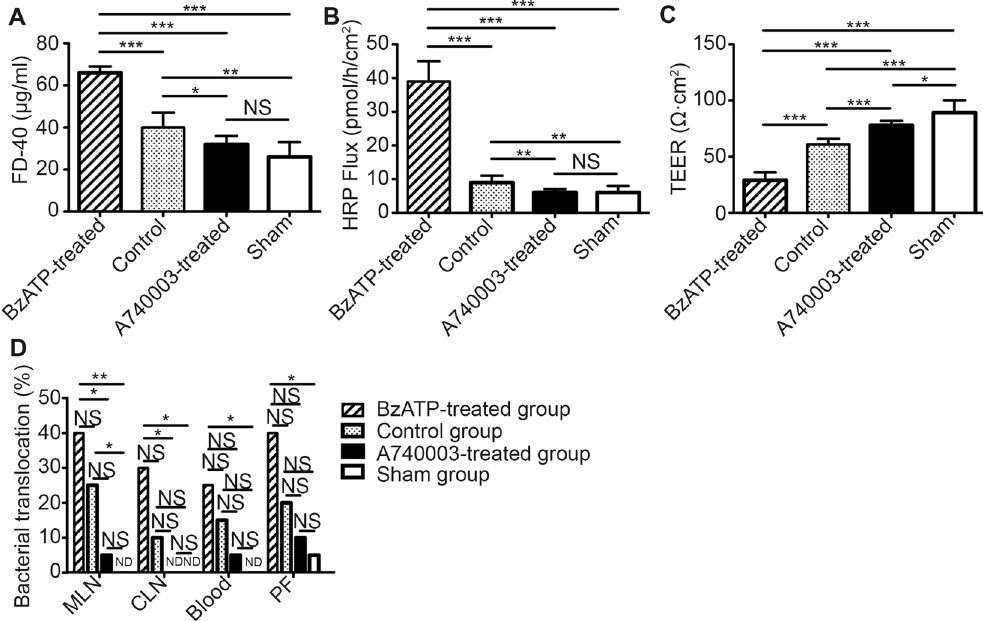
Figure 3. The effects of a P2X7R blockade on intestinal permeability and bacterial translocation. In vivo and in vitro permeability and bacterial translocation were assessed at 48 hours after CLP. ( A ) Mice in each group were fasted for 4 hours and then administered FD-40. Serum FD-40 was measured to evaluate in vivo permeability. ( B , C ) The in vitro permeability of the mouse intestines was measured by performing Ussing Chamber Analyses. ( D ) The MLN, CLN, blood, and PF were collected and cultured at 37 °C for 24 hours. The culture results of bacterial growth were considered positive when more than 10 2 colonies/g of tissue were found. N = 6 mice per group. The data are expressed as the means ± SD. * p < 0.05, ** p < 0.01 and *** p < 0.001 when compared among the different